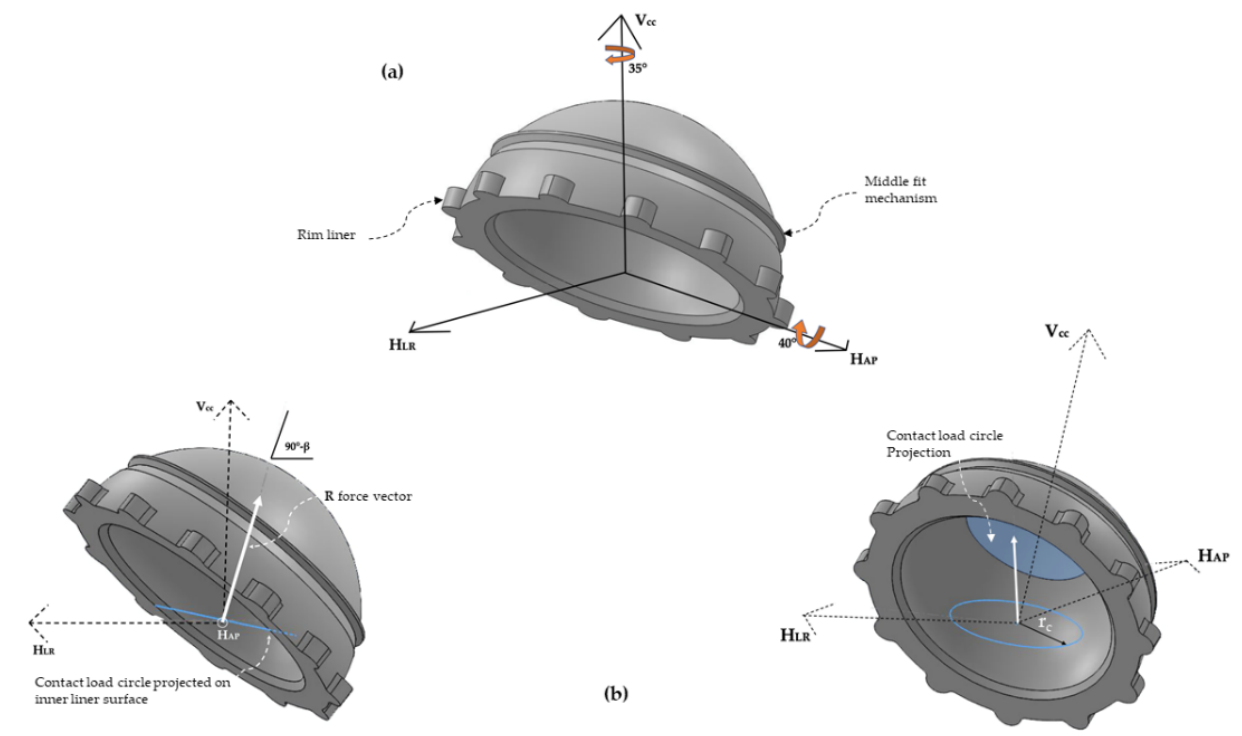
Figure 2. ( a ) 3D liner modeled with its orientation in the three-axis: HLR (Horizontal Left-Right or frontal); HAP (Horizontal Anteroposterior, Sagittal o Dorsoventral); VCC (Vertical Craniocaudal). ( b ) 3D liner with load vector R applied over the contact Hertz theory circle.